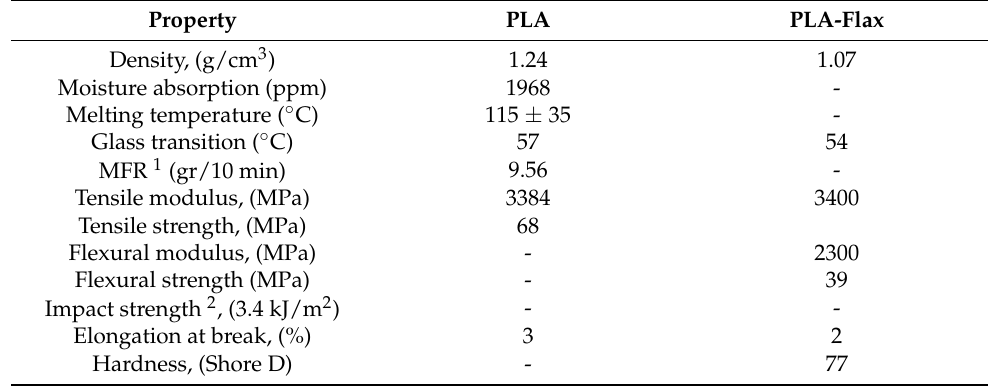
Table 1. Main characteristics of studied feedstock materials according to the supplier’s data sheet.